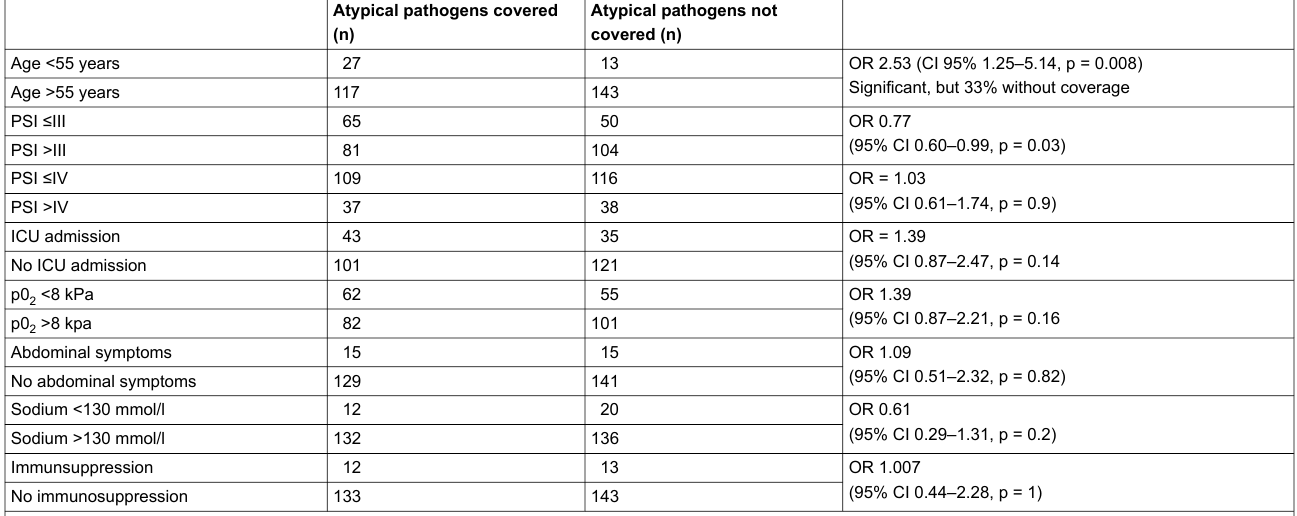
Table 1: Coverage of atypical pathogens in hospitalised patients with community-acquired pneumonia.